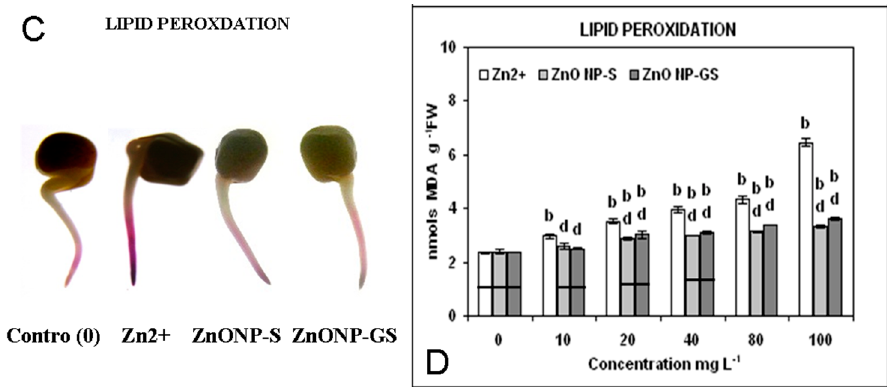
Figure 7. Cytochemical visualization of ( A ) cell death and ( C ) lipid peroxidation in roots of germinating seeds treated with Zn 2+ and ZnONPs at a single concentration (0 or 80 mg L − 1 ); Spectrophotmetric determination of ( B ) cell death and ( D ) in roots of germinating seeds of C. gigantea treated with Zn 2+ or ZnONPs at different concentrations (0–100 mg L − 1 ). Increase significant at p ≤ 0.01 (b) compared to the control (0), and decrease significant at p ≤ 0.01 (d) compared to Zn 2+ . The horizontal bar denotes no significant difference between the treatments at p ≤ 0.05, ( n = 6).